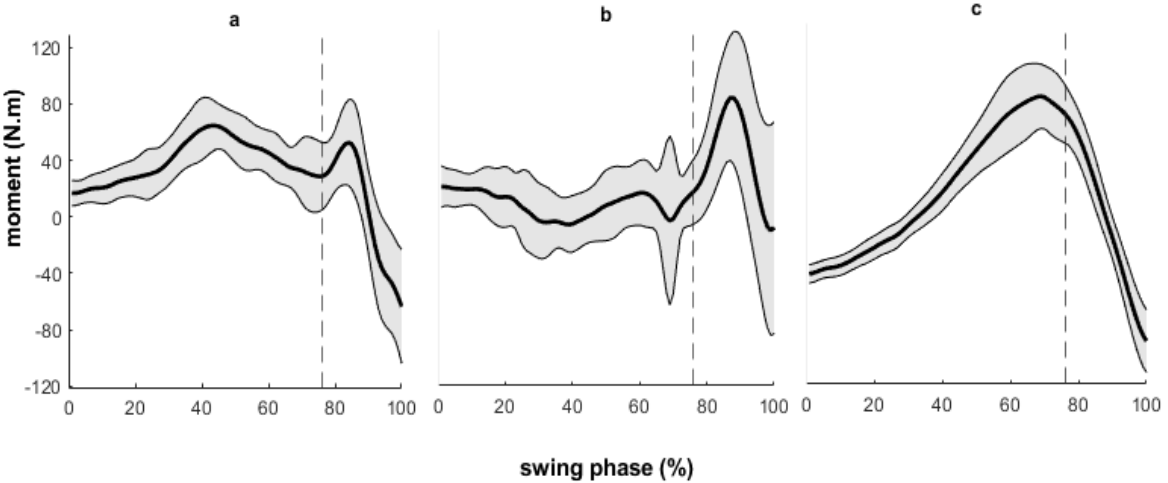
Figure 2. Normalised time histories for shoulder resultant moments: ( a ) shoulder forward plane of elevation [+]/backward plane of elevation [ − ]; ( b ) shoulder depression [+]/elevation [ − ] and ( c ). shoulder internal rotation [+]/external rotation [ − ]. Vertical dashed line indicates the mean end of back swing instant (Figure 1).